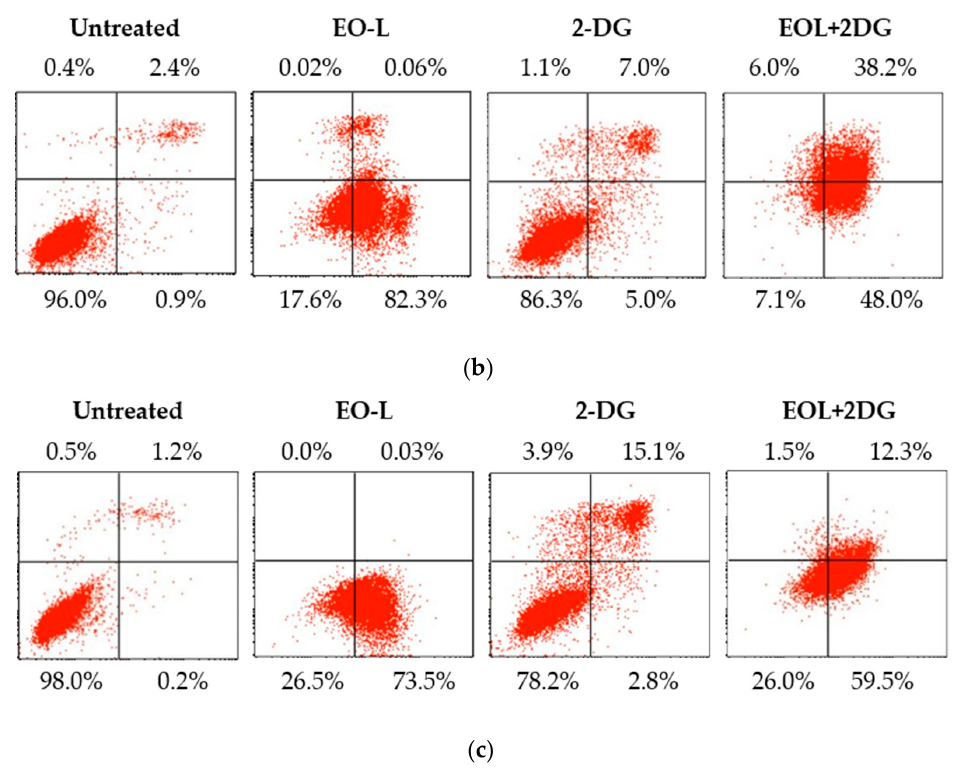
Figure 10. Representative cytogram of PANC-1 cells: PANC-1 cells were exposed to untreated (culture medium), EO-L, 2-DG and EOL+2DG for ( a ) 24 h, ( b ) 48 h and ( c ) 72 h. Quadrant location for the representative dot plots: lower left—FITC − /PI − (viable cells); lower right—FITC + /PI − (early apoptotic cells); upper right—FITC + /PI + (late apoptotic cells); and upper left—FITC − /PI + (necrotic cells).